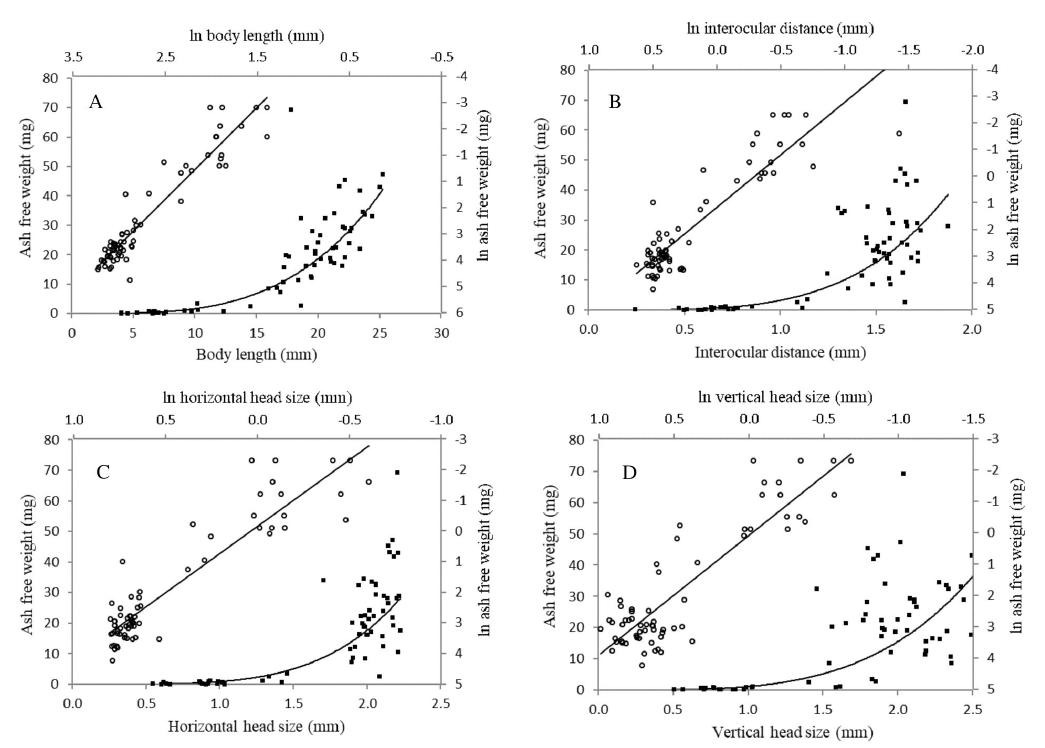
Figure 2. Length-mass curves for the Leptonema larvae from the Taboões stream for: body length (A), interocular distance (B), horizontal width of the cephalic capsule (C), and vertical width of the cephalic capsule (D), using both linear (open circles) and logarithmic (filled squares) scales. The power equation is DM = a L b , where DM = dry mass, L = linear length and a/b are